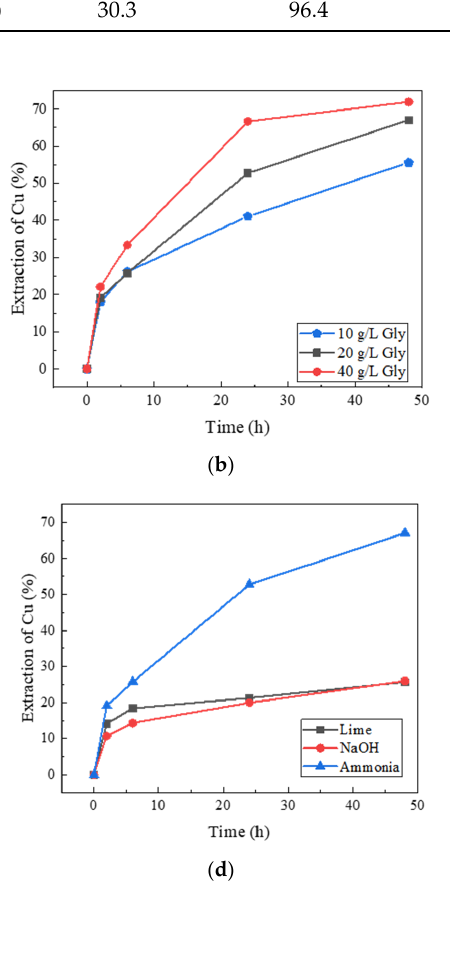
Table 3. Ammonia additions at different glycine concentrations (10 kg/t KMnO 4 (stg. addit.), with a pH level of 10.5, with 30% solids and at 30 ◦ C). Glycine Concentration, g/L 10 20 40 23.3 46.7 93.3 30.3 96.4 156.7